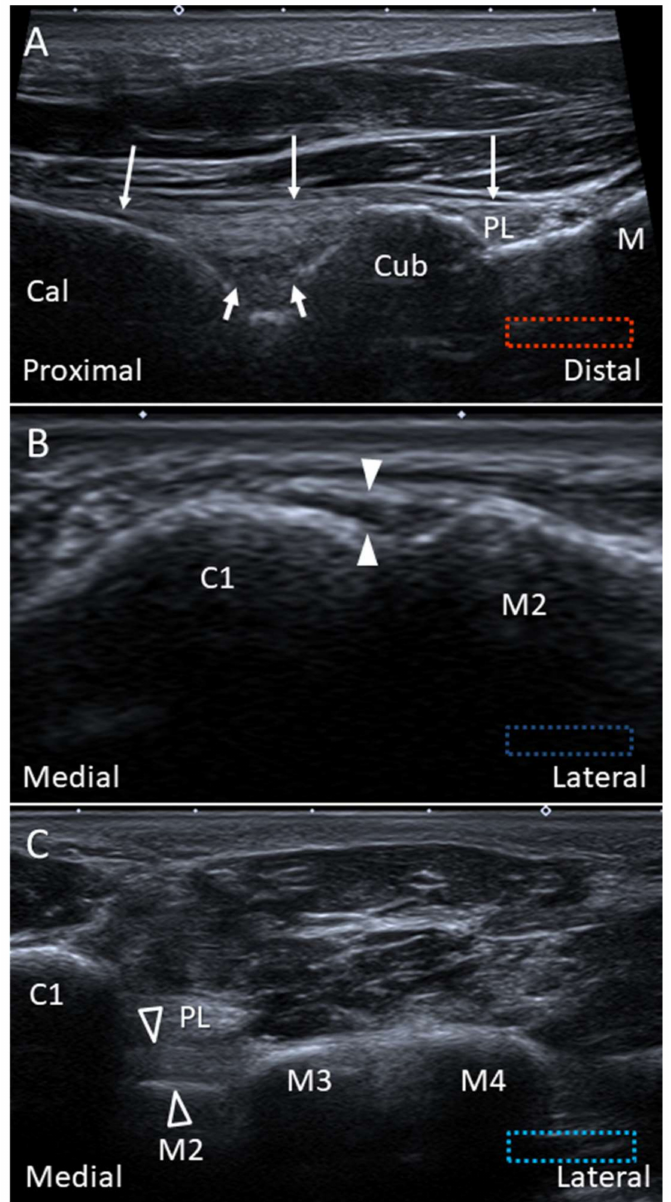
Figure 13. Imaging of the long (thin arrows) and short plantar (thick arrows) ligaments ( A ), dorsal (white arrowheads) ( B ) and plantar (void arrowheads) ( C ) Lisfranc ligaments. Cal: calcaneus; Cub: cuboid; C1: medial cuneiform; M2: 2nd metatarsal bone: M3: 3rd metatarsal bone; M4: 4th metatarsal bone; PL: peroneus